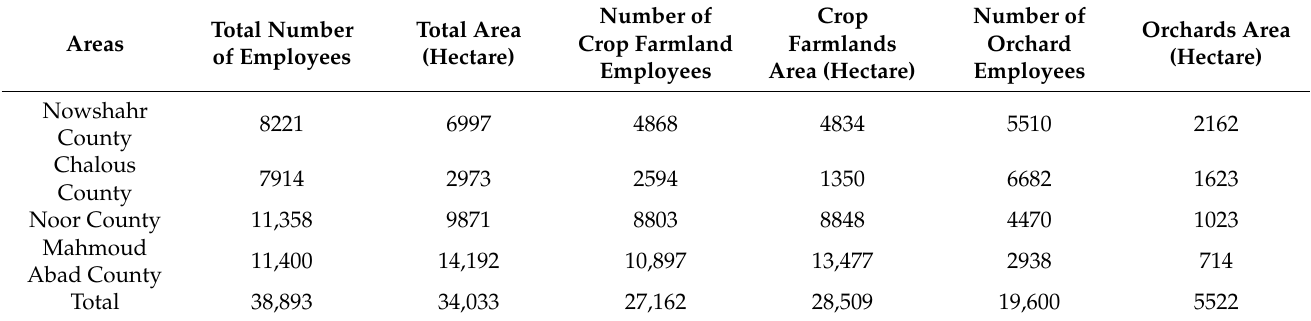
Table 2. Number of employees and area of the agricultural lands in the study area in 2016